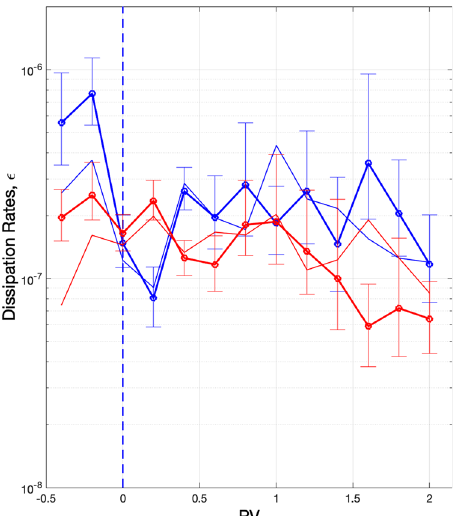
Fig. 9 Relation between measured dissipation rates and potential vorticity during November 2019 cruise. Average turbulent kinetic energy dissipation rates (log 10 W kg − 1 ) measured during November 2019 cruise as a function of PV (10 – 9 m – 1 s – 1 ). Solid lines are PV (Eq. (3) in “ Methods ” ) computed with the vertical shear of the lateral velocity measured by the ADCP data with error bars, 95% con fi dence interval for (red) leg 1 and (blue) leg 2. Thin solid lines are PV computed with the geostrophic vertical shear (see “ Methods ”